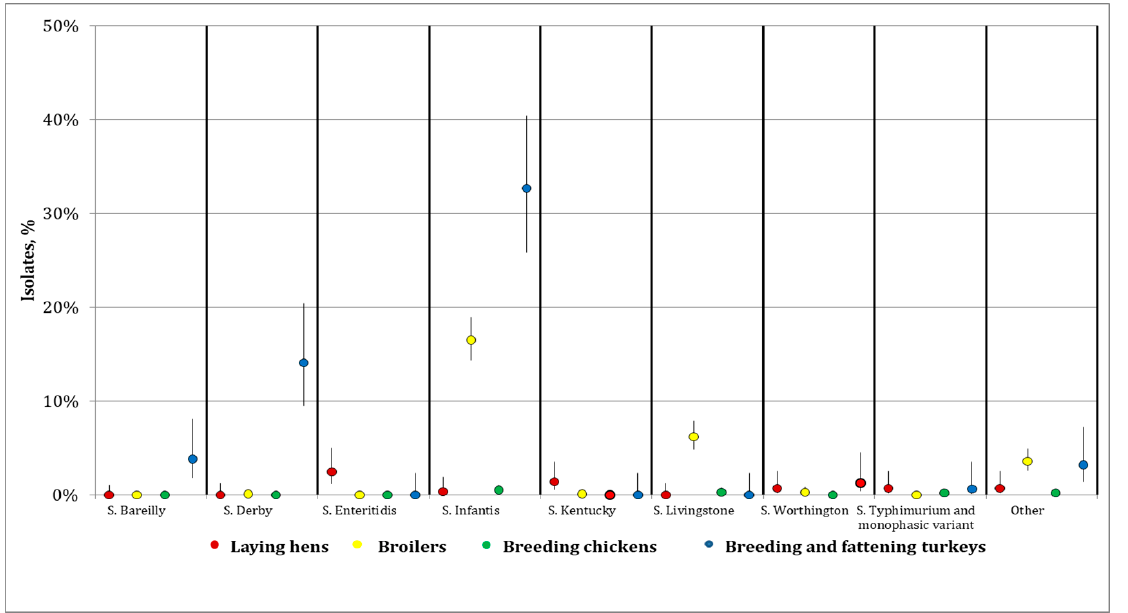
Figure 3. Distribution of Salmonella spp. serotypes by flock category.